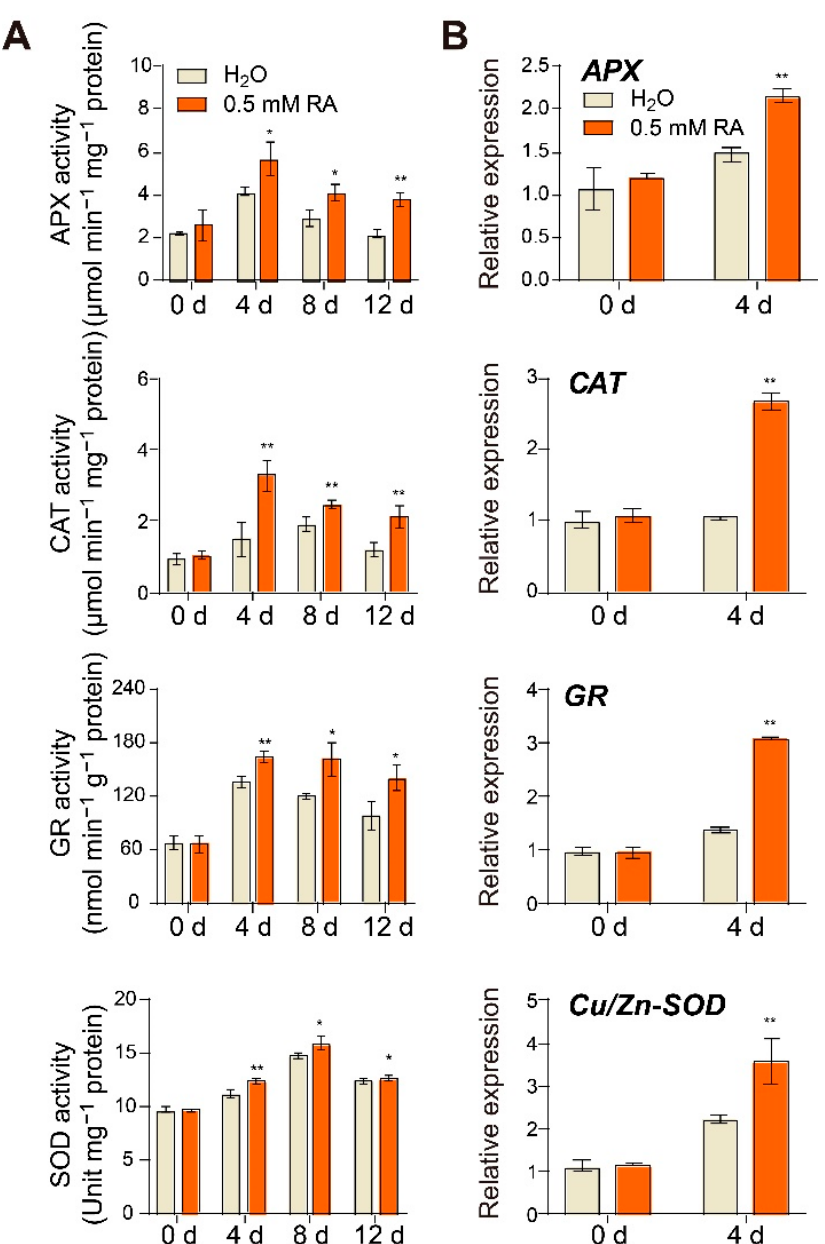
Figure 5. RA promoted transcript abundance and enzyme activity of antioxidant enzymes during fruit ripening. Effects of RA treatment on ( A ) antioxidant enzyme activity and ( B ) transcript abun- dance of antioxidant enzyme encoding genes. The transcript abundance of each gene under control at 0 d was defined as 1. APX, ascorbate peroxidase; CAT, catalase; GR, glutathione reductase; SOD, superoxide dismutase. Tomato fruits at the mature green stage were treated with 0.5 mM RA, or H 2 O control. The fruit samples were collected at the indicated time points for qRT-PCR and enzyme activity analysis. The data are presented as mean values ± SD; n = 4 in ( A ), 3 in ( B ). Asterisks indicate statistically significant differences (* p ≤ 0.05, ** p ≤ 0.01) compared with control under the same time point, as determined by Student’s t -test.